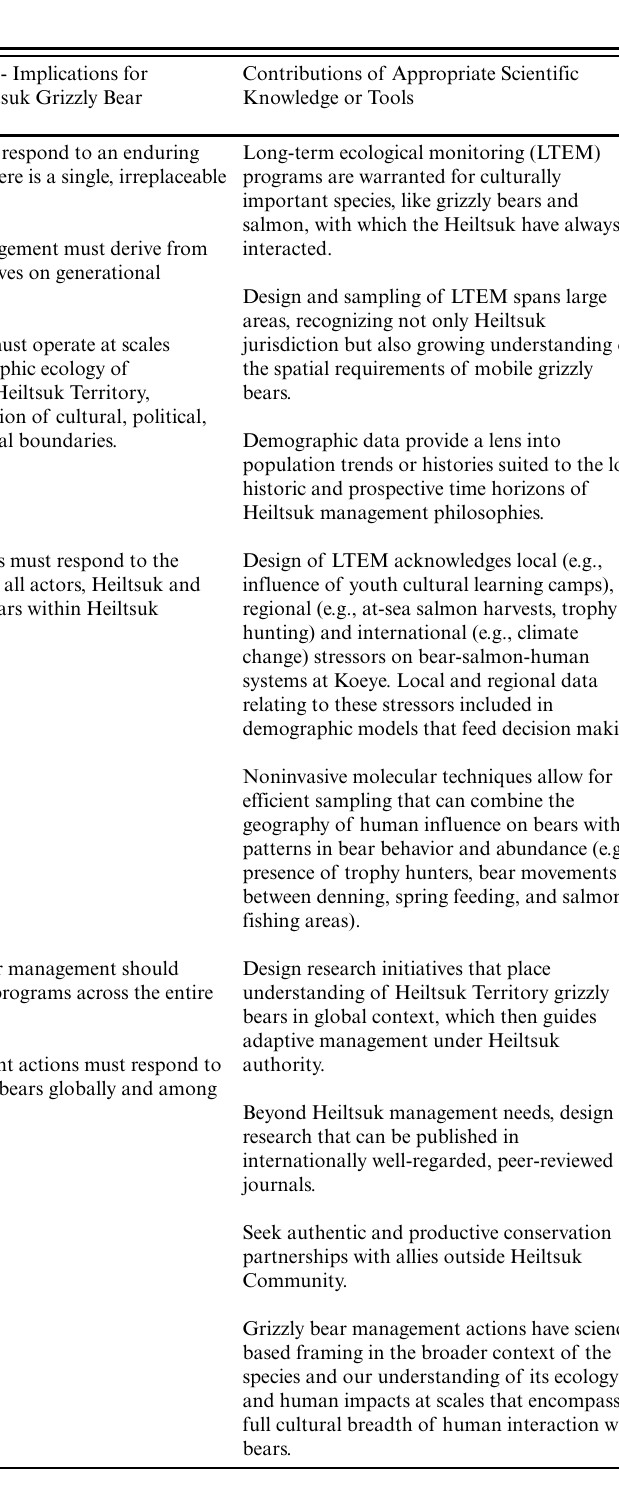
Table 1 . Summary of exemplary principles from Heiltsuk First NationÂ’s Lhaxvai (authority or power of place) and GviÂ’ilas (customary law) that frame the management issues and scientific questions addressed by Heiltsuk grizzly bear ( Ursus arctos horribilis ) research. As with GviÂ’’ilas generally, principles are not specific to individual actions or resources. This table illustrates how cultural values guide empirical research methods that matter to Heiltsuk people. Linkages across columns present, verbally, the social framing of the Â“research action arenaÂ” (see text) that legitimized scientific knowledge and is fostering science-based action through Heiltsuk grizzly bear